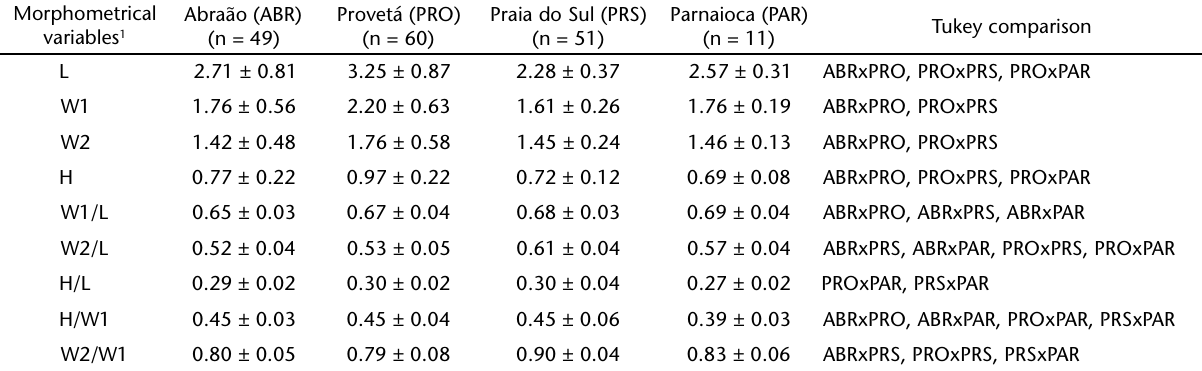
Table II. Morphological analysis of G. ticaga shells from four sites on Ilha Grande, Angra dos Reis, Rio de Janeiro, Brazil. Average and standard deviation (mm). Significant differences in Tukey pairwise comparison are shown in last column. Morphometrical variables 1